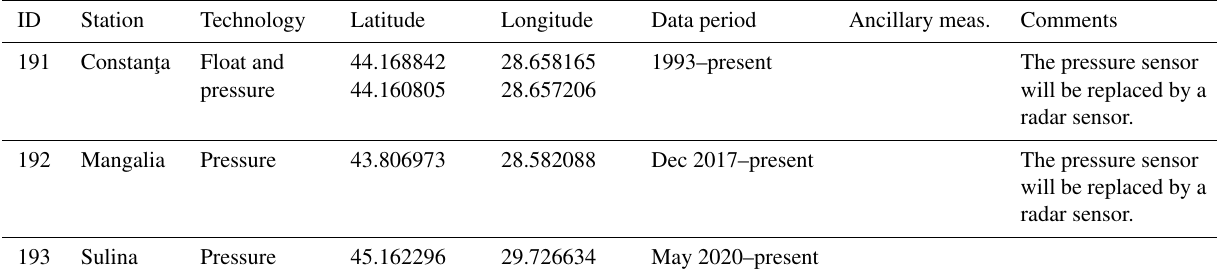
Table A19. Stations operated by NIMRD “Grigore Antipa”,